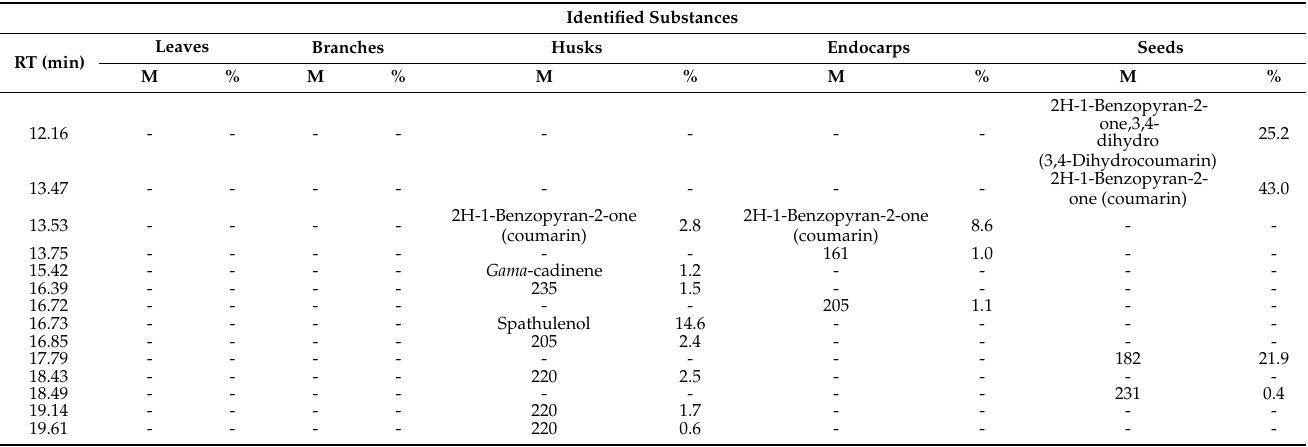
Table 3. Chemical constituents of ethanolic extracts of Dipteryx punctata characterized by gas chro- matography coupled to mass spectrometry